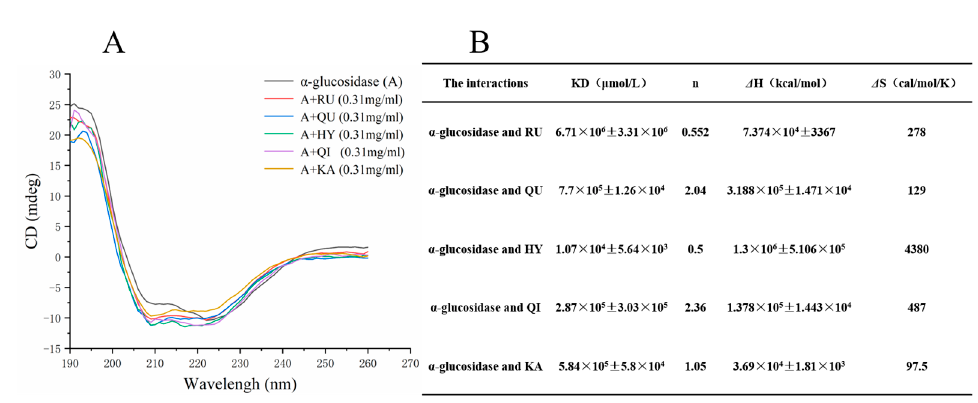
Figure 3. CD spectra of α -glucosidase with RU, QU, HY, QI, KA ( A ). The contents of secondary structures of α -glucosidase in absence or presence of RU, QU, HY, QI, KA at pH = 6.9 T = 298 K ( B ). RU represents rutin, QU represents quercetin, HY represents hyperoside, QI represents quercitrin, KA represents, kaempferol.